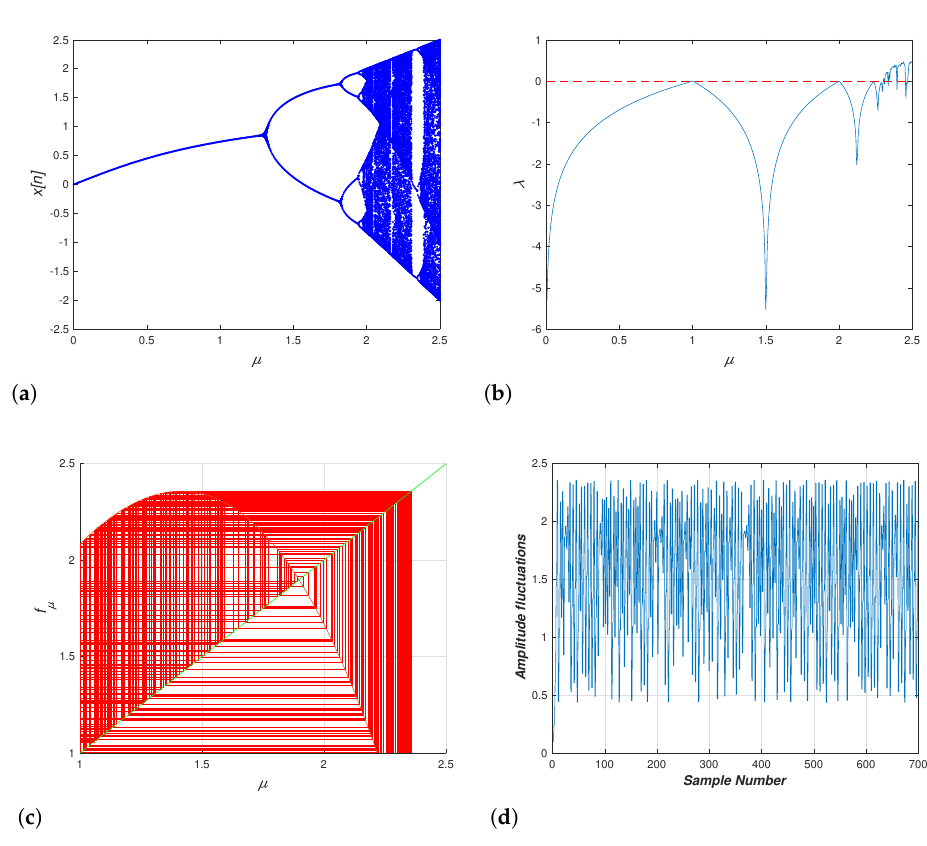
Figure 1. Chaotic invariants for approximated discrete–time Sine Map: ( a ) Bifurcation Diagram, ( b ) Lyapunov Exponent, ( c ) Cobweb Plot, ( d ) Pseudo Space Trajectory, ( e ) Time